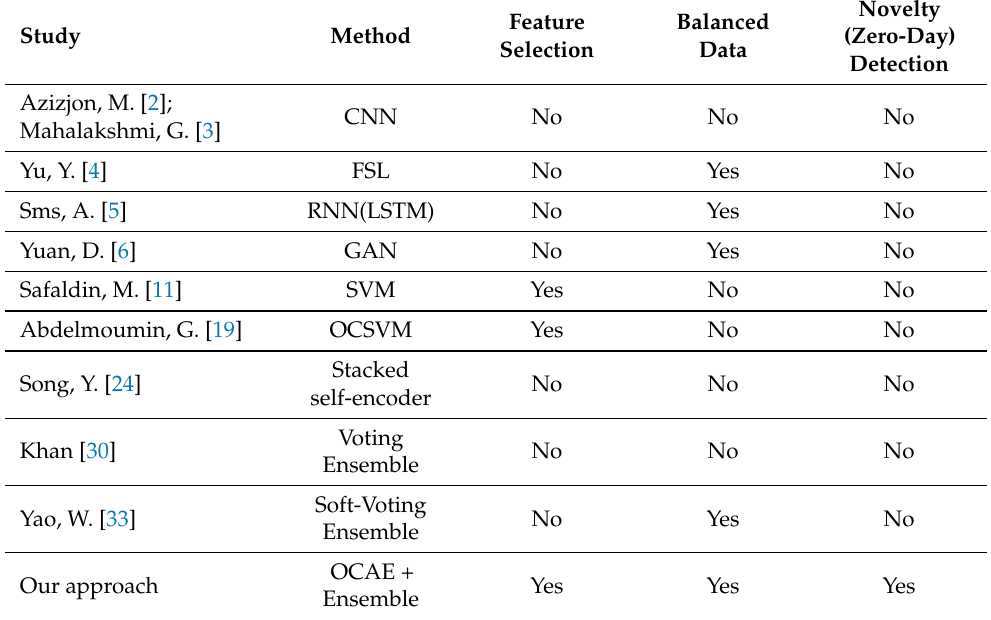
Figure 2. NIDS model classification (our research domain is the OC-AE. Furthermore, we use the Ensemble model). Table 1. Comparision of our approach and related